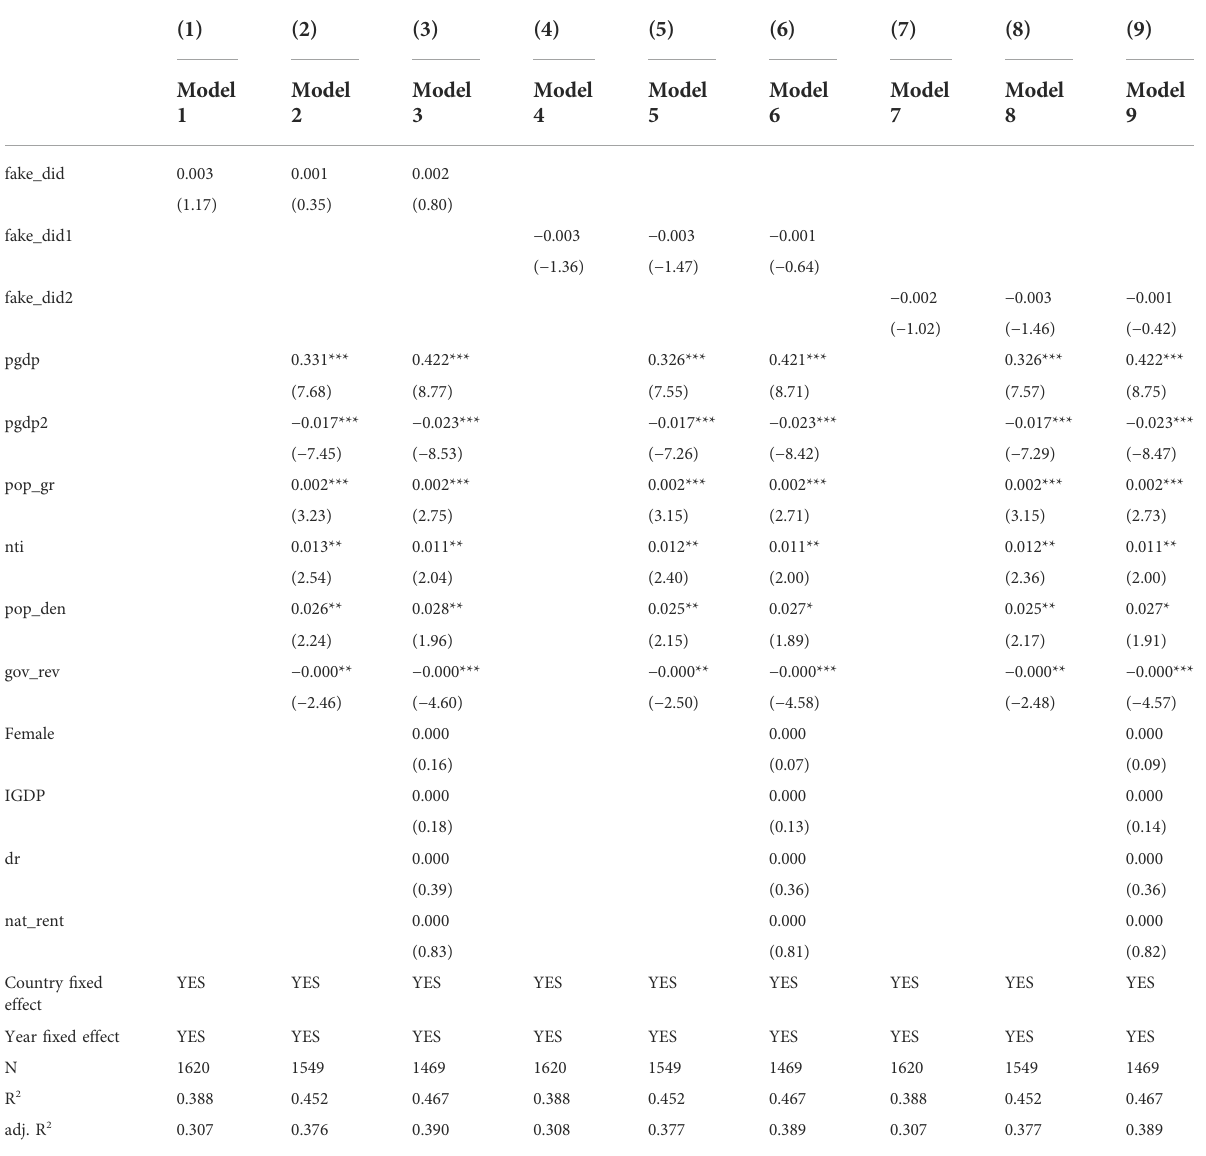
TABLE 10 Effects of the Belt and Road Initiative on environmental quality: Placebo